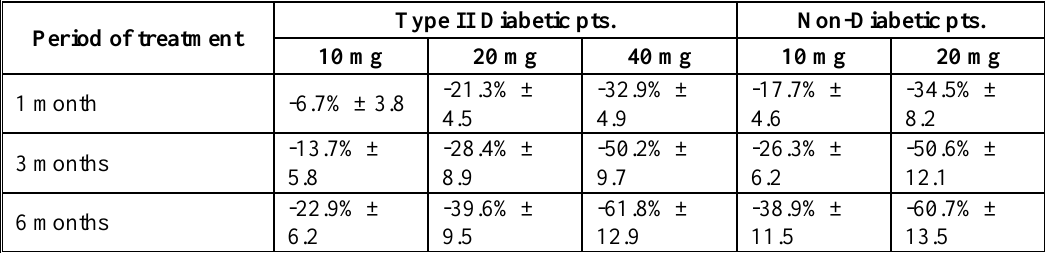
Table 2: Percentage of serum LDL-Cholesterol reduction after treatment with Atorvastatin* Type II Diabetic pts. Period of treatment